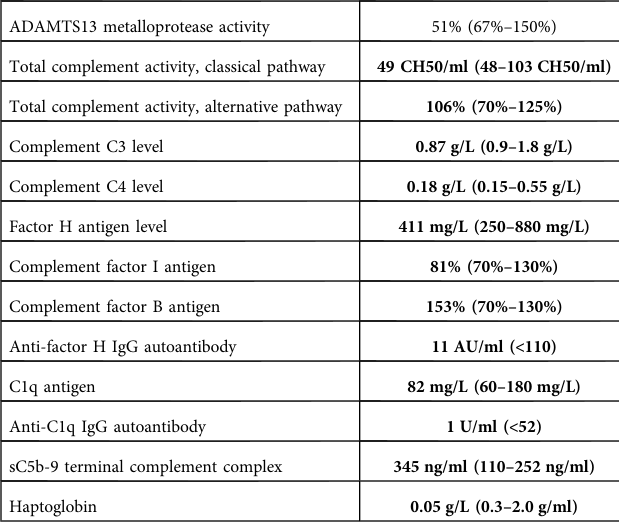
TABLE 3 Additional fi ndings of complement pathway testing.